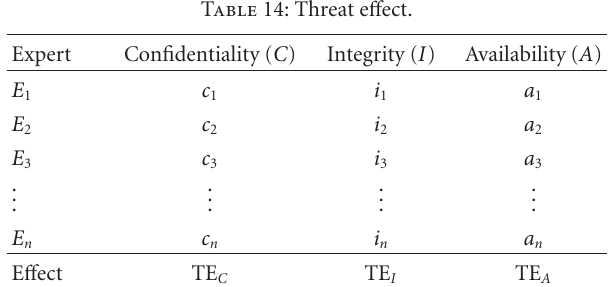
Table 14: Threat e ff